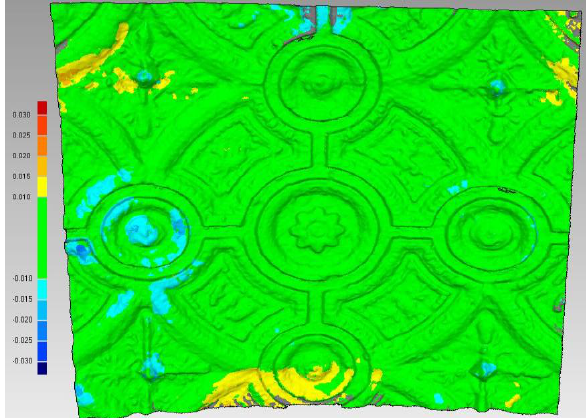
Figure 13 – The displacement map shows only small differences between the decorations coming from the two rooms; some decay in the plaster should be considered (medium distance between surfaces is 6 mm; standard deviation is 1